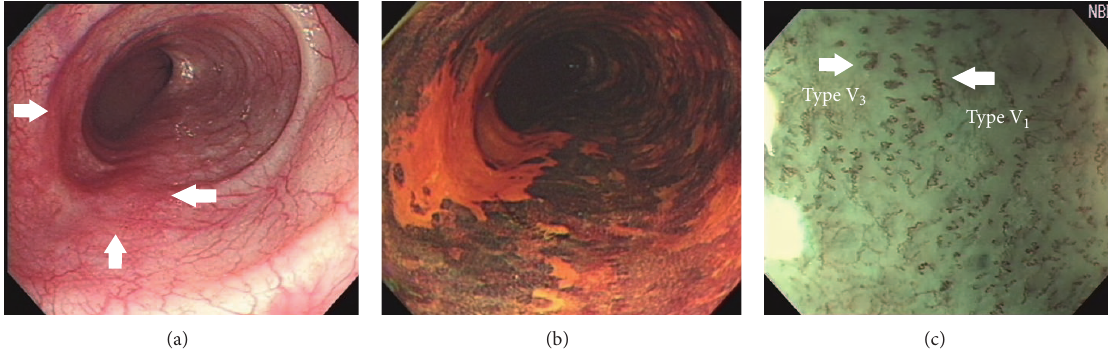
Figure 6: (a) White-light imaging endoscopy shows a type 0-IIb lesion with mildly hyperemic change of mucosal surface. (b) Chromoendoscopy after spraying 1.5% Lugol’s solution discloses Lugol-unstained appearance. (c) Magnifying endoscopy with narrow-band imaging system reveals abnormal superficial vessels (Inoue’s classification of intraepithelial papillary capillary loops type